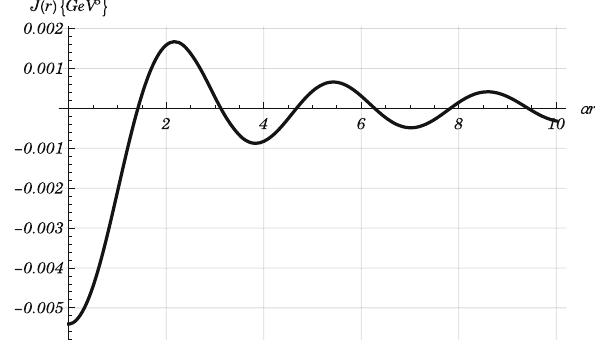
Fig. 1 Neutrino current as a function of r (distance from the cosmic string). Here α r is dimensionless